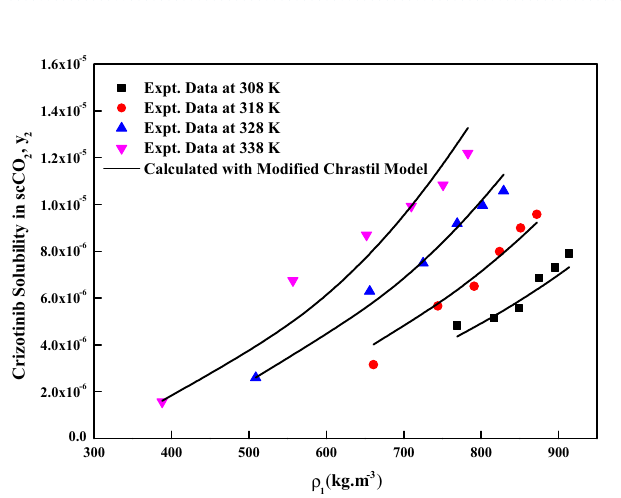
Figure 3. Crizotinib solubility in scCO 2 versus ρ 1 . Symbols are experimental data points. Solid lines are calculated solubilities with Chrastil model.